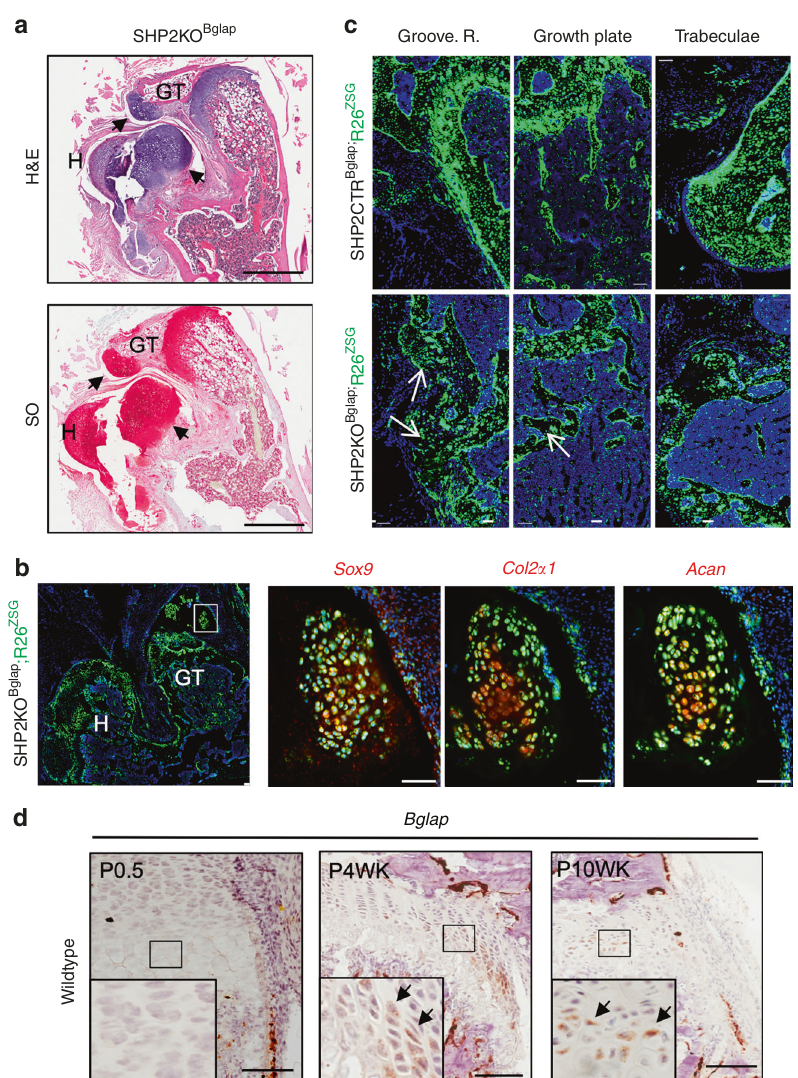
Fig. 6 SHP2 deletion in Bglap + chondroid cells leads to the growth of enchondromas and osteochondromas. a H&E- and SO-stained proximal femoral sections show the existence of cartilaginous enchondromas and osteochondromas in 13-week-old SHP2KO Bglap mice. H femur head, GT great trochanter, Scale bar: 1 mm. b Proximal femoral frozen sections reveal enchondromas comprised of R26 ZSG + cells that also express Sox9 , Col2 α 1 , and Acan , as determined by RNAScope ® assays. Scale bar: 100 μ m. Green: R26 ZSG reporter; red: RNAScope pseudocolor for the indicated probes. c Frozen tibial sections exhibit R26 ZSG -positive cells in the groove of Ranvier, growth plate, and trabeculae in 13-week-old controls and SHP2 mutants. Scale bar: 100 μ m. d Frozen tibial sections show Bglap transcript abundance in the growth plate chondrocytes of postnatal 0.5-day-old, 4- and 10-week-old mice detected using RNAScope ® assays. Enlarged view of the boxed areas shown at the bottom left. Bglap + cells marked by arrows. Scale bar: 100 μ